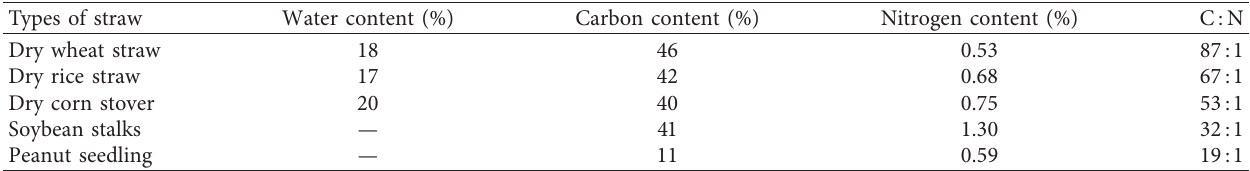
Table 2: C: N of straw of major crops.